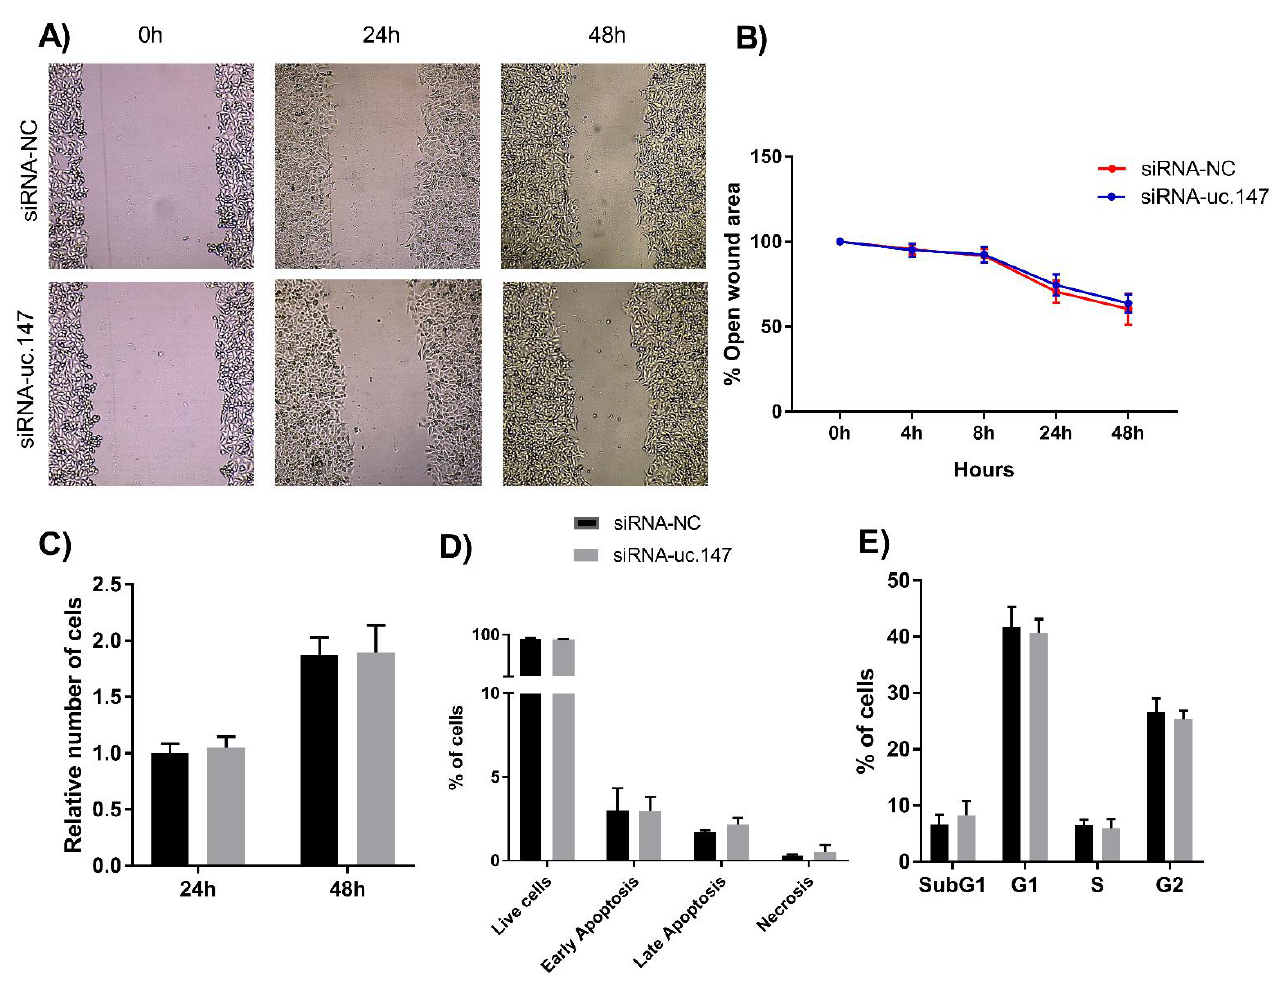
Figure 2. Migration, proliferation, apoptosis, and cell cycle assays. ( A ) Representative images of migration assay of HepG2 cells treated with siRNA-uc.147 and negative control at 0, 24, and 48 h after the scratch. ( B ) Percentage of open-wound area of migration assay at 0, 4, 8, 24, and 48 h. ( C ) Proliferation assay demonstrating the relative number of cells after 24 and 48 h. ( D ) Percentage of live, early apoptotic, late apoptotic, and necrotic cells after staining with Annexin-V/PI, and treatment with siRNAs. ( E ) Percentage of cells in the different stages of the cell cycle and SubG1 after staining with PI. For all experiments, three independent experiments are represented.